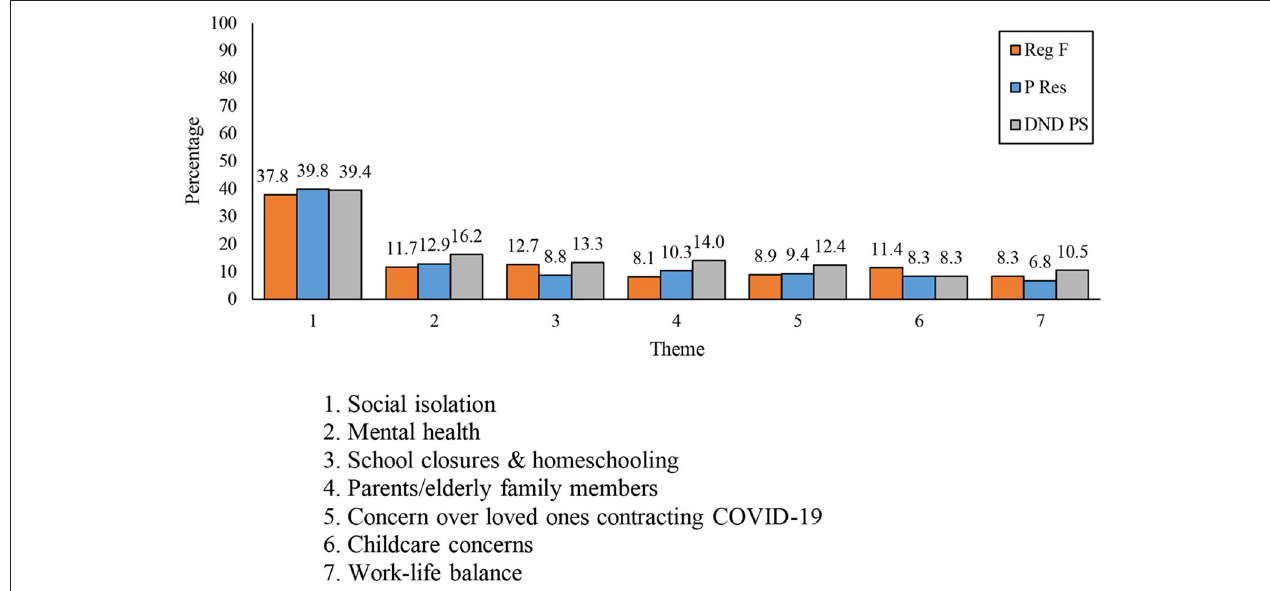
FIGURE 4 | Differences between components of respondent in the frequency of the seven themes